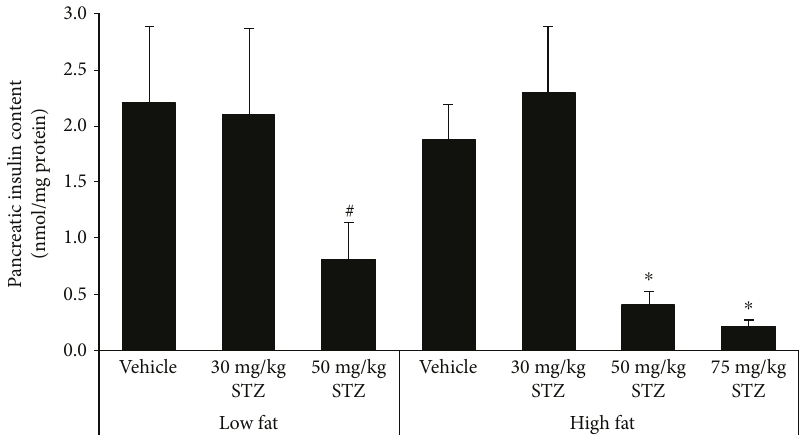
Figure 5: Pancreatic insulin content in low and high fat-fed mice treated with three consecutive once-daily doses of vehicle or 30, 50, or 75mg/kg STZ. Data are means ± SEM . Low fat — vehicle, n = 4 ; low fat — 30mg/kg STZ, n = 4 ; low fat — 50 mg/kg STZ, n = 4 ; high fat — vehicle, n = 4 ; high fat — 30 mg/kg STZ, n = 3 ; high fat — 50mg/kg STZ, n = 6 ; high fat — 75 mg/kg STZ, n = 3 . # p ≤ 0 05 versus low fat — vehicle, ∗ p < 0 05 versus high fat — vehicle.